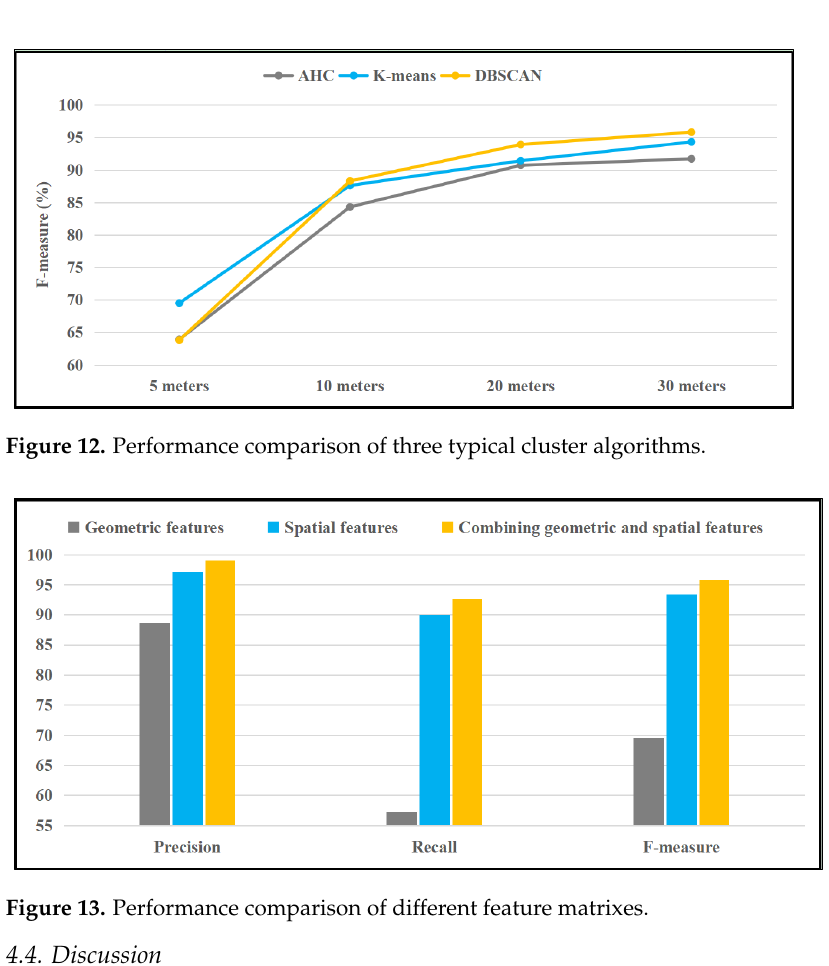
( b ) Figure 11. Performance comparison between Tang’s method [2] and our method of radius compu- ting and center coordinate detection: ( a ) The average error of computing radius of intersections; ( b ) The accuracy of detecting center coordinate of intersections. 4.3. Performance Comparison of Clustering Algorithms and Feature Matrixes To select a suitable clustering algorithm for our approach, we devise a comparison experiment among three typical clustering algorithms: the Agglomerative Hierarchical